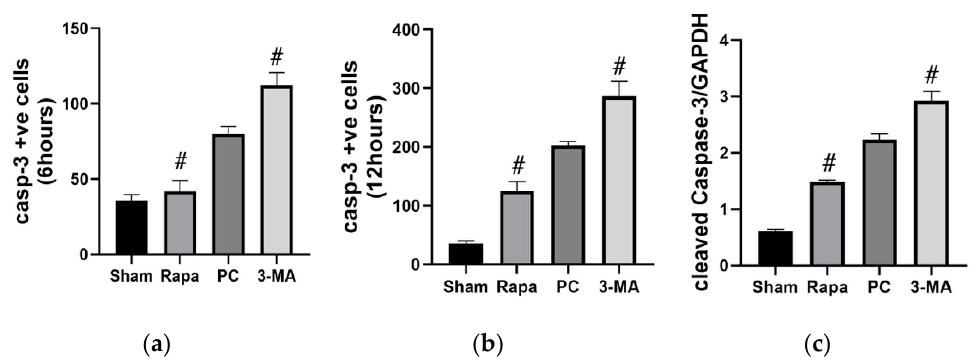
Figure 5. Changes in apoptosis after autophagy regulation. Panels ( a ) and ( b ) represent quantitative apoptotic cell counts for positively stained caspase-3 cells at 6 and 12 h, respectively. Panel ( c ) shows changes in expression of cleaved caspase-3 after 12 h of preservation. Data are mean ± SEM, n = 6. # p ≤ 0.05 versus PC. Representative electrophoresis pattern for cleaved caspase-3 is available as Supplementary Material (S3).